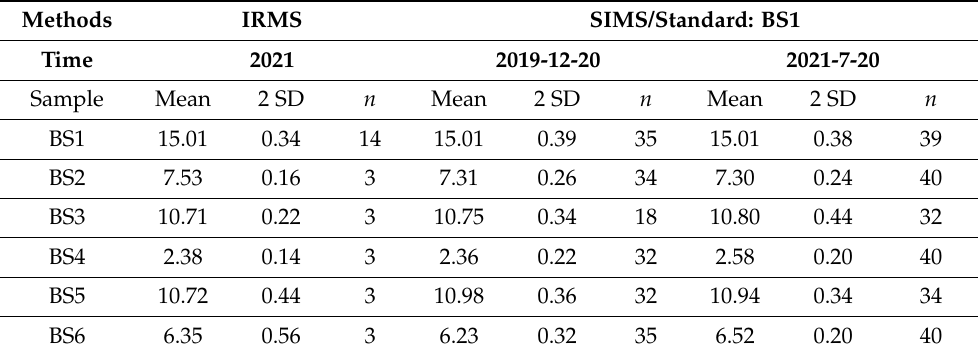
Table 3. The oxygen isotopes obtained by IRMS and